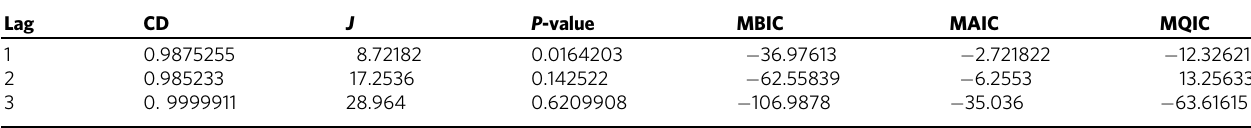
Table 5 Optimal lag selection